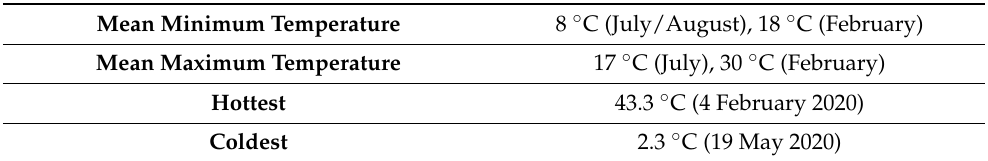
Table 2. Temperature History (information supplied by Weatherzone based on data from the Bureau of Meteorology) [35].